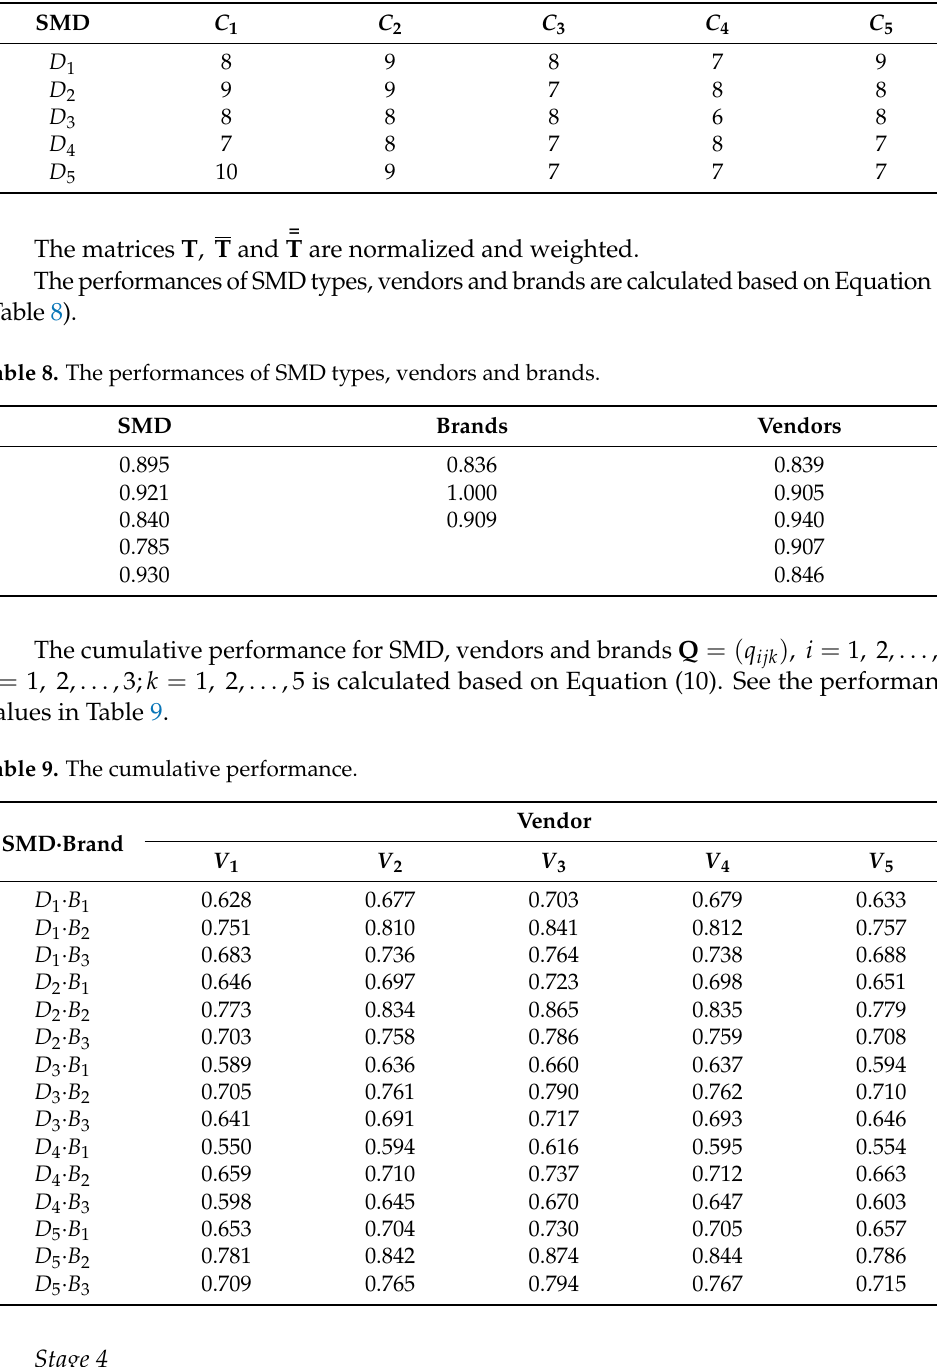
Table 7. The evaluation matrix T .